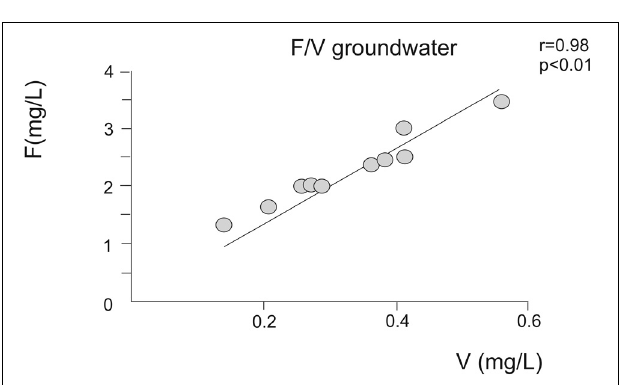
FIGURE 5 | Correlations between F − and V in